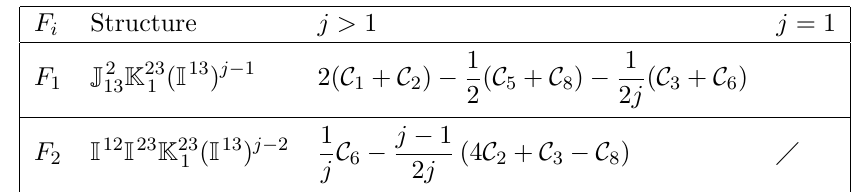
Table 13 . Expansion of the supersymmetric correlator in the component spin (0 ; 1 ( j 1)). The unbarred entry in the j = 1 column is obtained by setting 2 (cid:0)